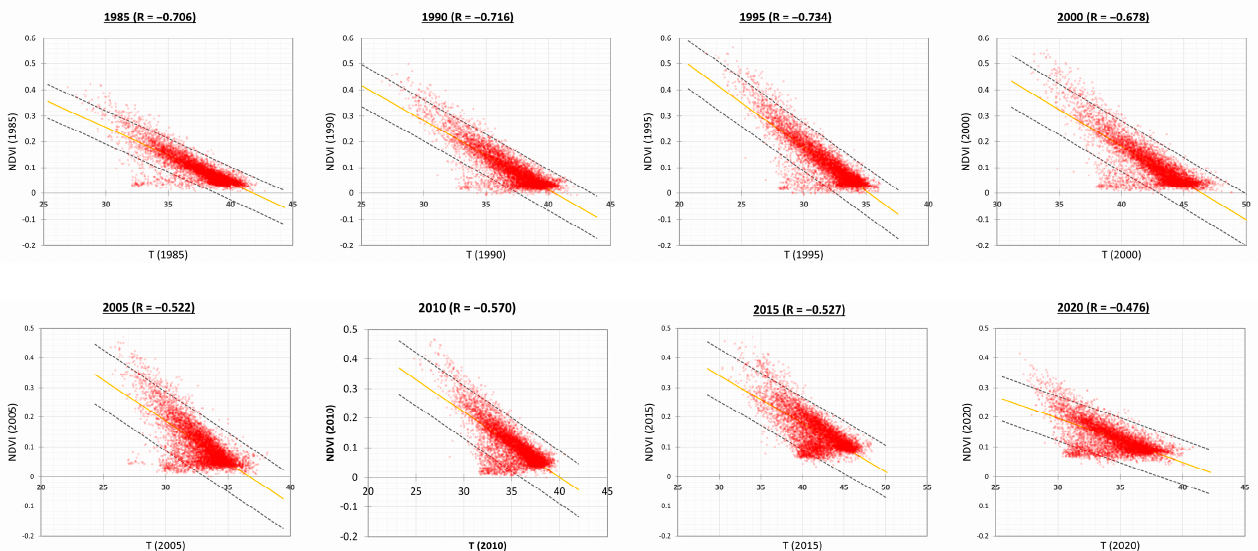
Figure 7. Relationship between LST and NDVI from 1985 to 2020.